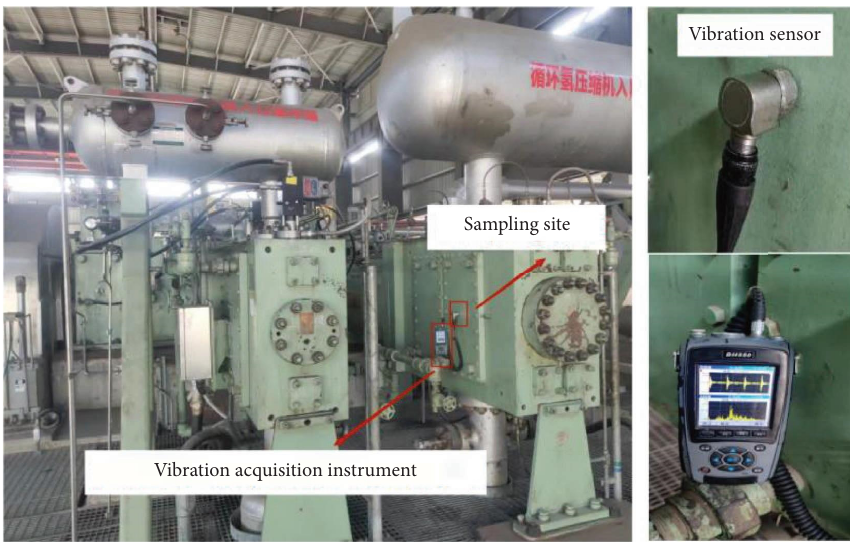
Figure 17: Real-time vibration data acquisition of a reciprocating compressor.